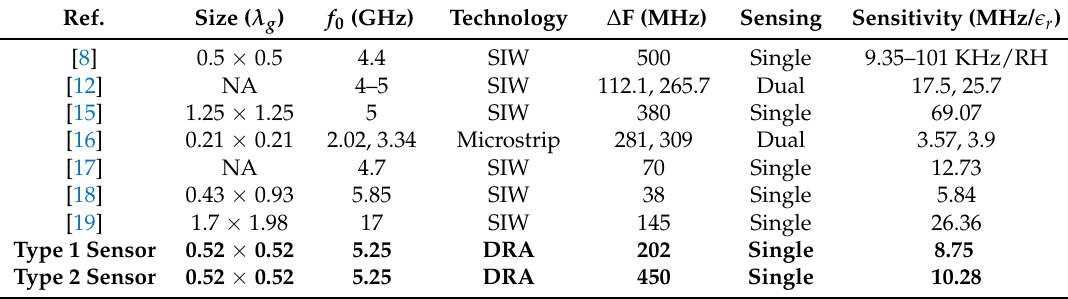
Table 3. Comparison with the already designed